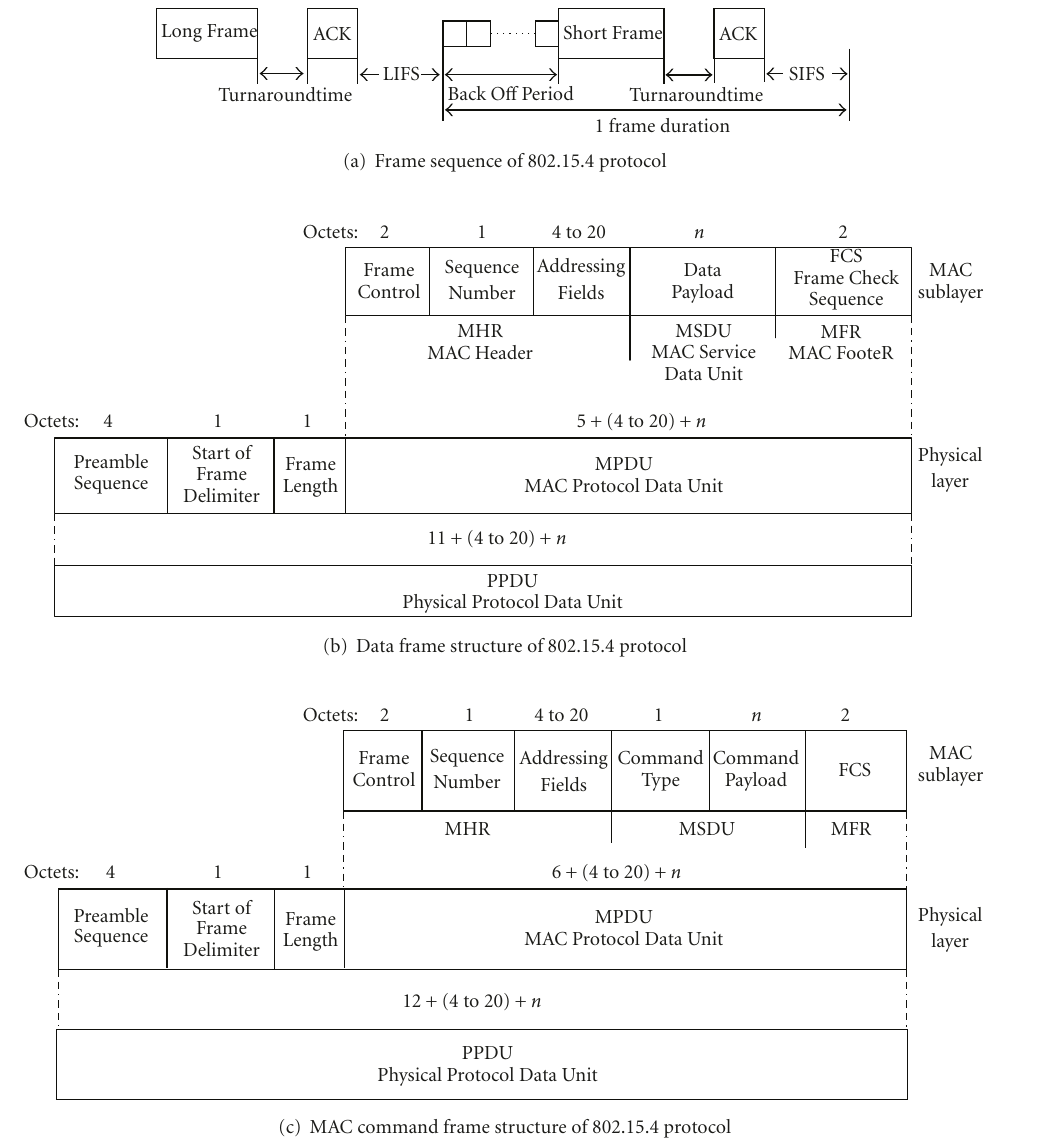
Figure 8: IEEE 802.15.4 frame sequence, data, and command frame